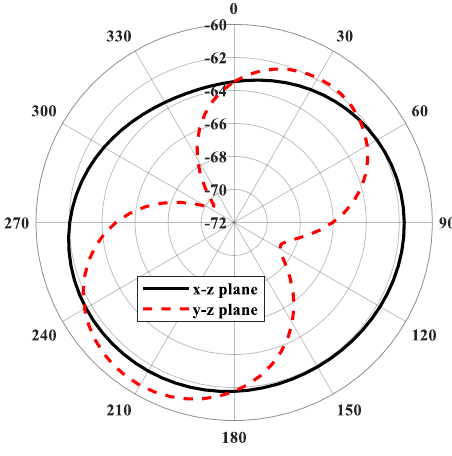
Figure 13. Simulated radiation patterns of the antenna. Table 4. Capacitance of the antenna versus frequency.